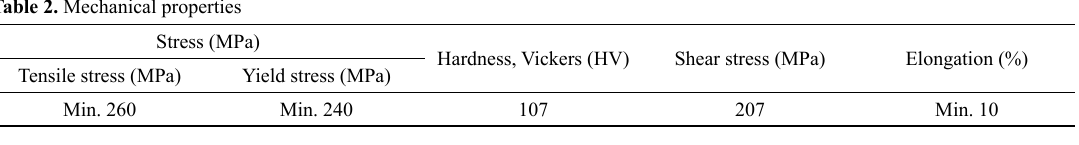
Table 3. Process parameter matrix - LSS (N)